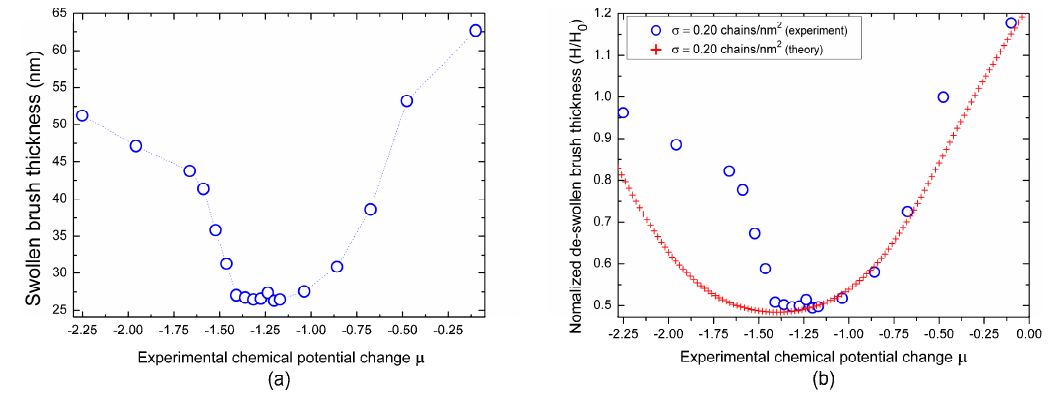
Figure 2. ( a ) Cononsolvency transition of a PNiPAAm brush ( σ = 0.20 chains/nm 2 ) in water/ethanol mixtures with reference to the swollen brush thickness as a function of experimental chemical potential change. Note that the dashed line is only used to guide eyesight. ( b ) Theoretical fitting of normalized de-swollen brush thickness plotted with respect to experimental chemical potential change in cononsolvency transition of a PNiPAAm brush.